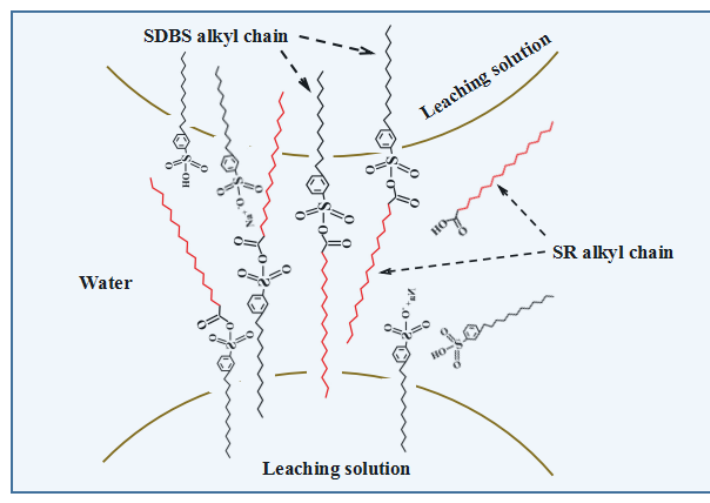
Figure 8. and SR form complex on the water leaching solution interface. Figure 8. And SR form complex on the water leaching solution interface. Table 8. Rate of water content of phosphogypsum after the modification of the compound surfactants.